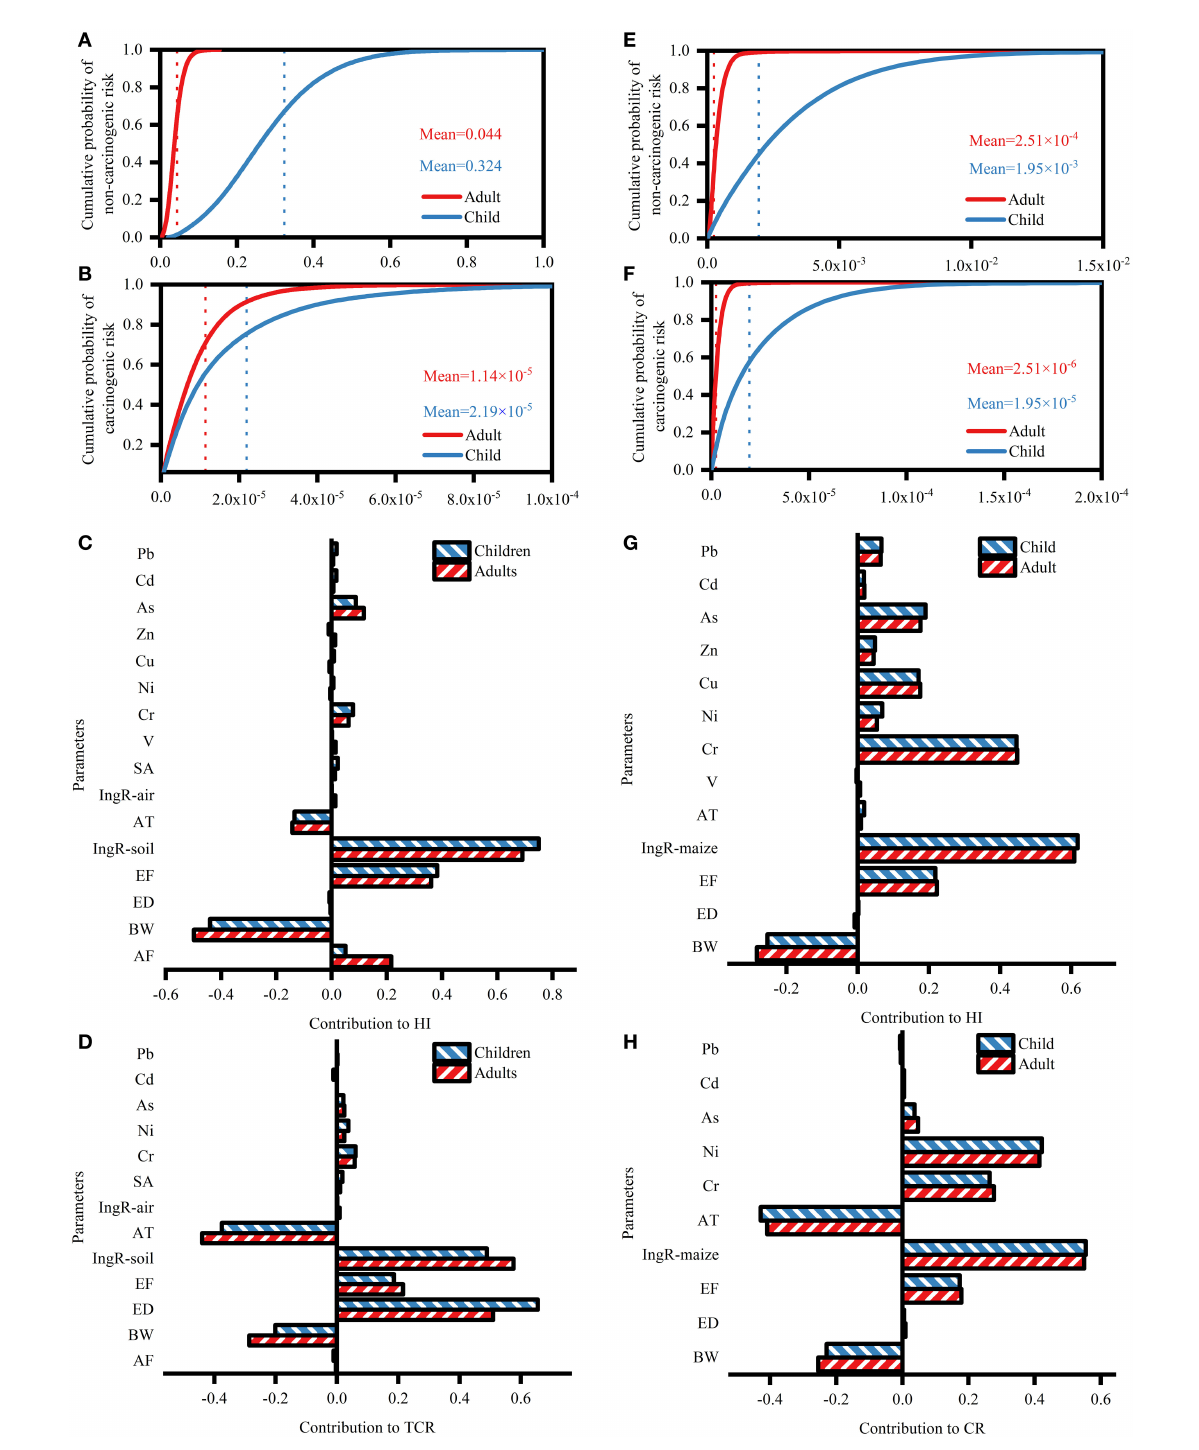
FIGURE4 The health risk assessment of heavy metal. (A) Probability distribution of hazard index (HI) and (B) total cancer risk (CR) in soil. (the blue or red dashed vertical lines presented the mean values for adults and children); (C) Contribution of different exposure parameters to hazard index (HI) and (D) total cancer risk (TCR) in soil; (E) Probability distribution of hazard index (HI) and (F) total cancer risk (CR) in maize. (The blue or red dashed vertical lines presented the mean values for adults and children); (G) Contribution of different exposure parameters to hazard index (HI) and (H) total cancer risk (TCR) in